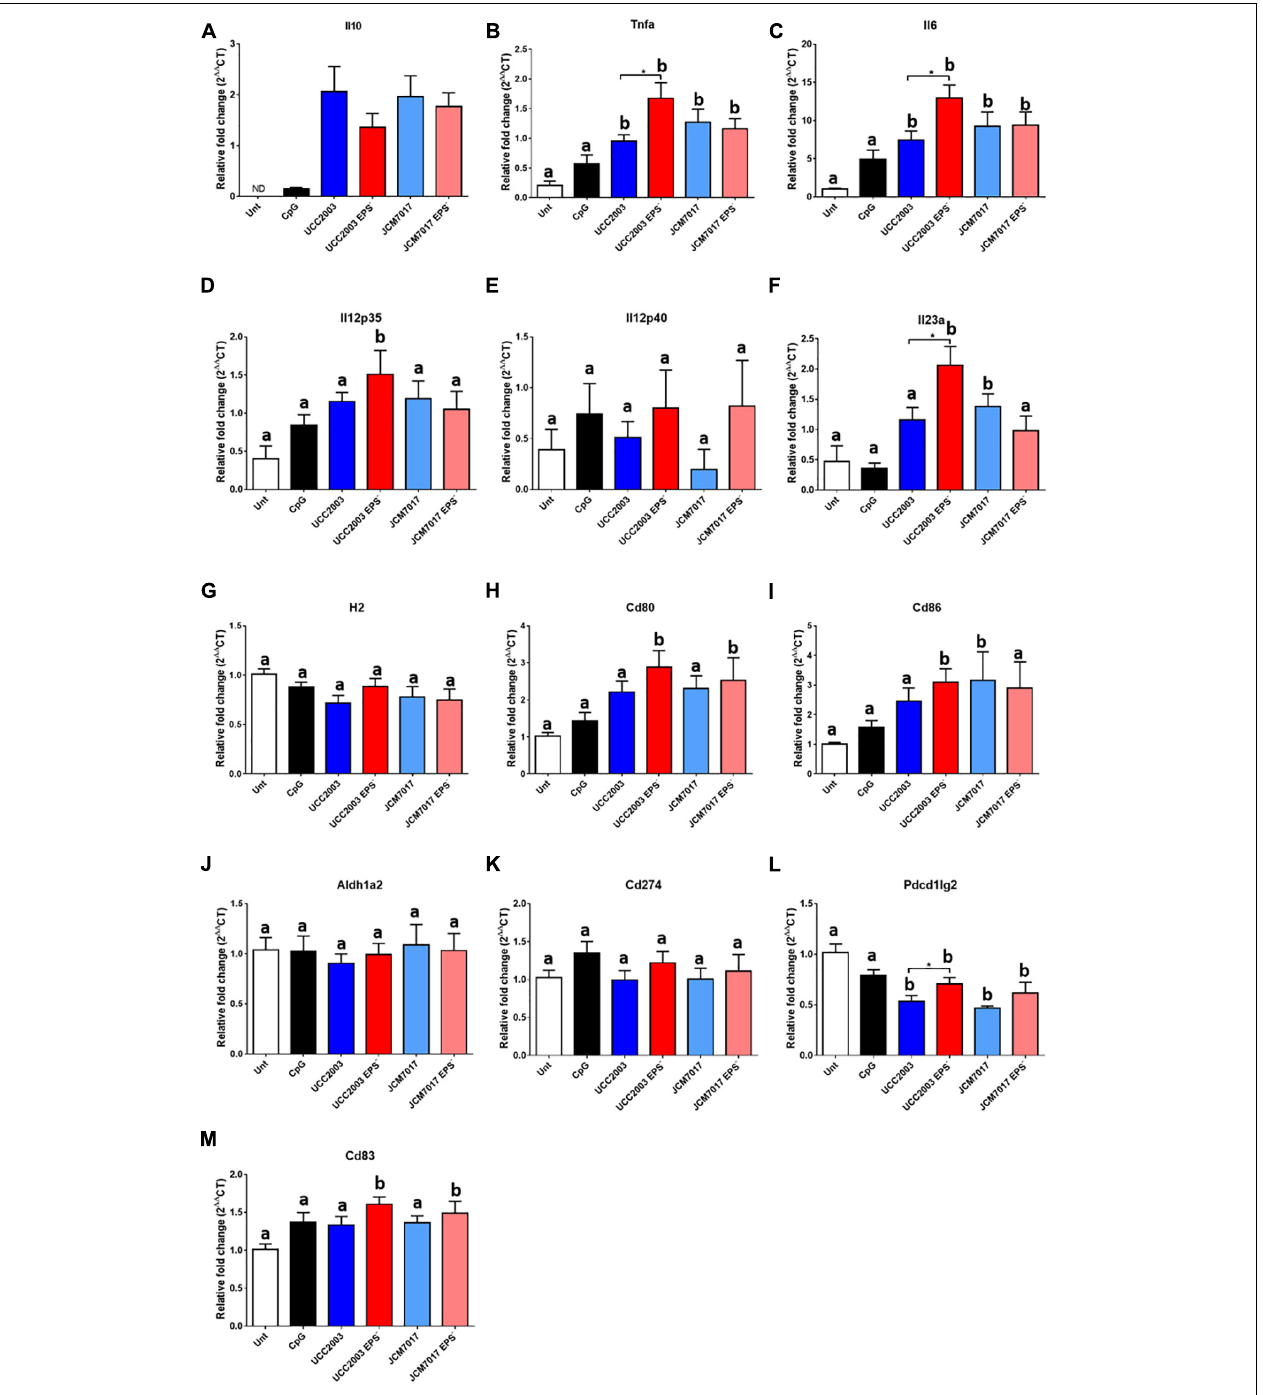
FIGURE 5 | EPS modulates the expression of immunomodulatory genes in BMDCs. Sorted BMDCs were co-cultured or not [untreated (Unt)] with B. breve strains as indicated (CpG was used as a positive control) for 4 h. RT-qPCR was carried out and the expression of (A–F) cytokine genes (G–I) antigen presentation and co-stimulatory genes and (J–M) tolerogenic genes were assessed. Expression changes are relative to β -actin. Data show the average of three independent experiments. Gene expression differences between the groups were compared first with the untreated control. Different letters (a and b) indicate statistical difference for each presented gene expression. Letter a indicates no statistical difference between the indicated group and the untreated control, letter b indicates significant differences between the indicated group and the untreated control ( p < 0.05 of Dunnett’s test). Then, the student t -test was used to compare wild type Bifidobacteria (both UCC2003 and JCM7017) with their isogenic EPS mutants (* p -value < 0.05 and ** p -value < 0.005).